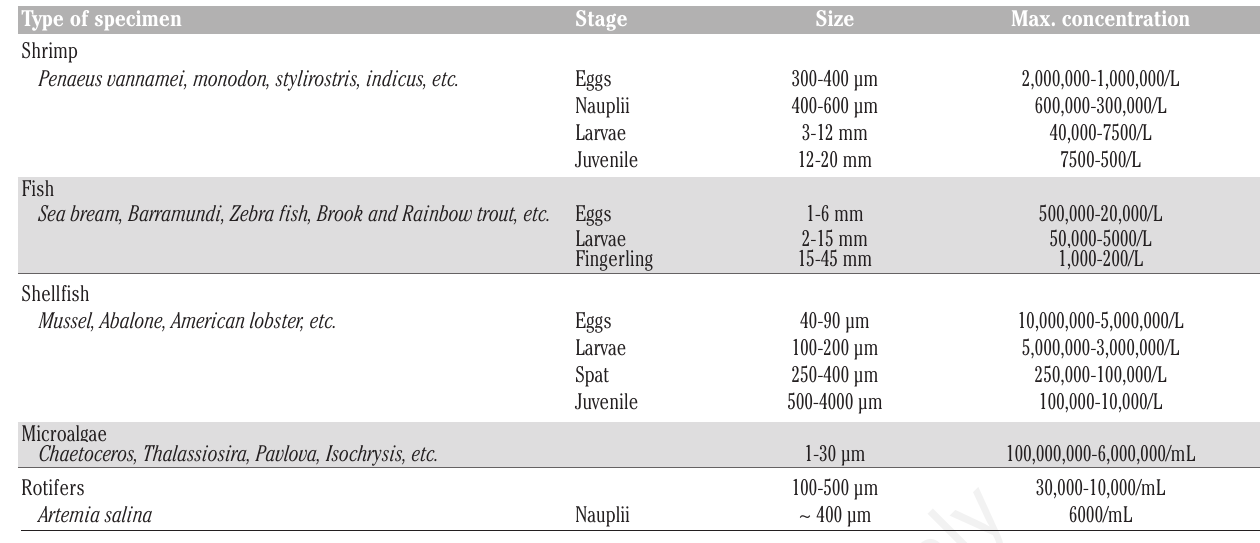
Table 3. Different counting applications developed for the XperCount. Type of specimen